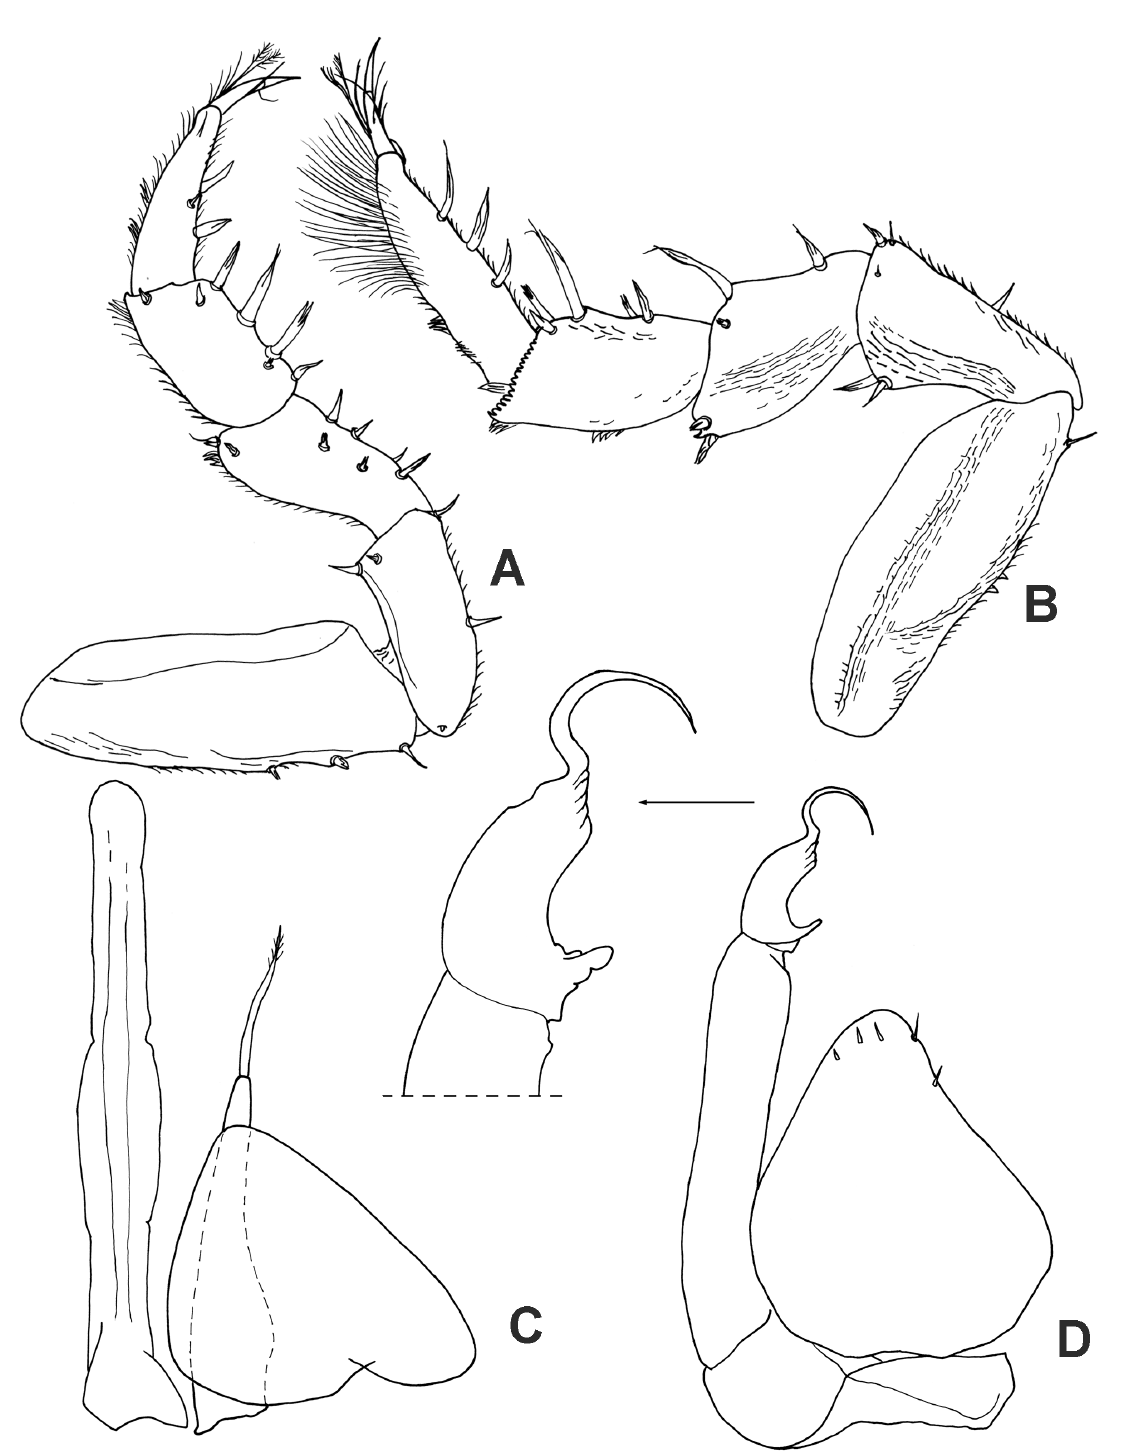
Fig. 15. Troglonethes olissipoensis Reboleira & Taiti sp. nov. from Gruta de Alvide, Lisbon Peninsula, paratype, ♂. A . Pereopod 1. B . Pereopod 7. C . Genital papilla and pleopod 1. D . Pleopod